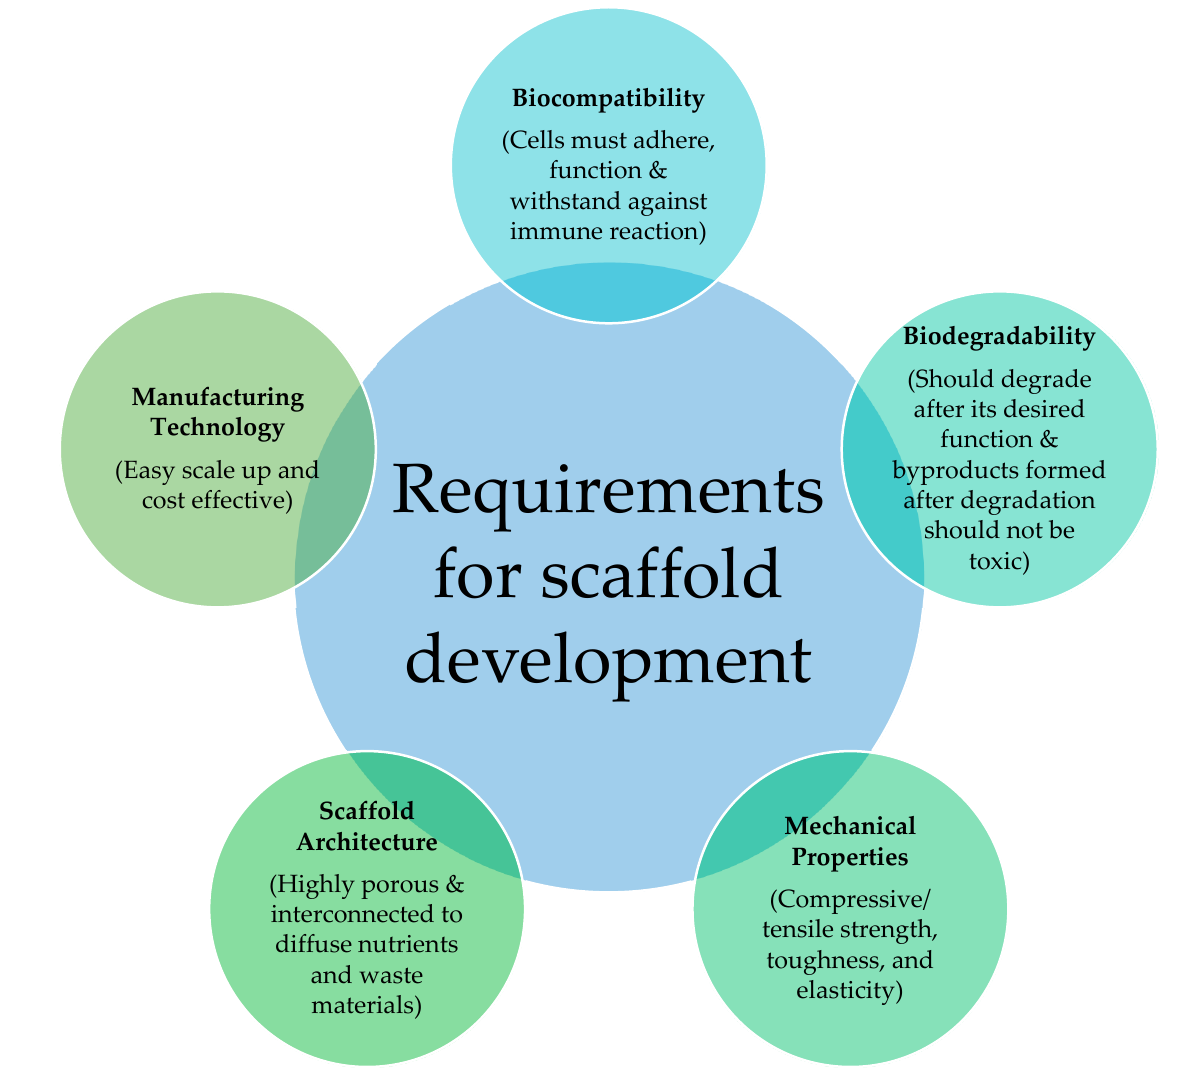
Figure 3. The necessary ideal scaffold requirements include biocompatibility, biodegradability, mechanical properties, scaffold architecture, and manufacturing technology.